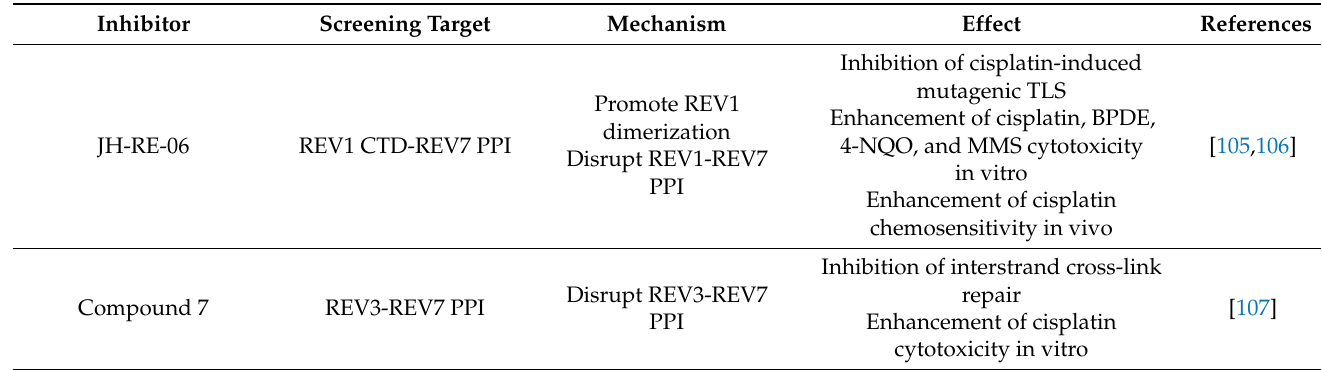
Table 1. List of inhibitors targeting REV1/Pol ζ -associated